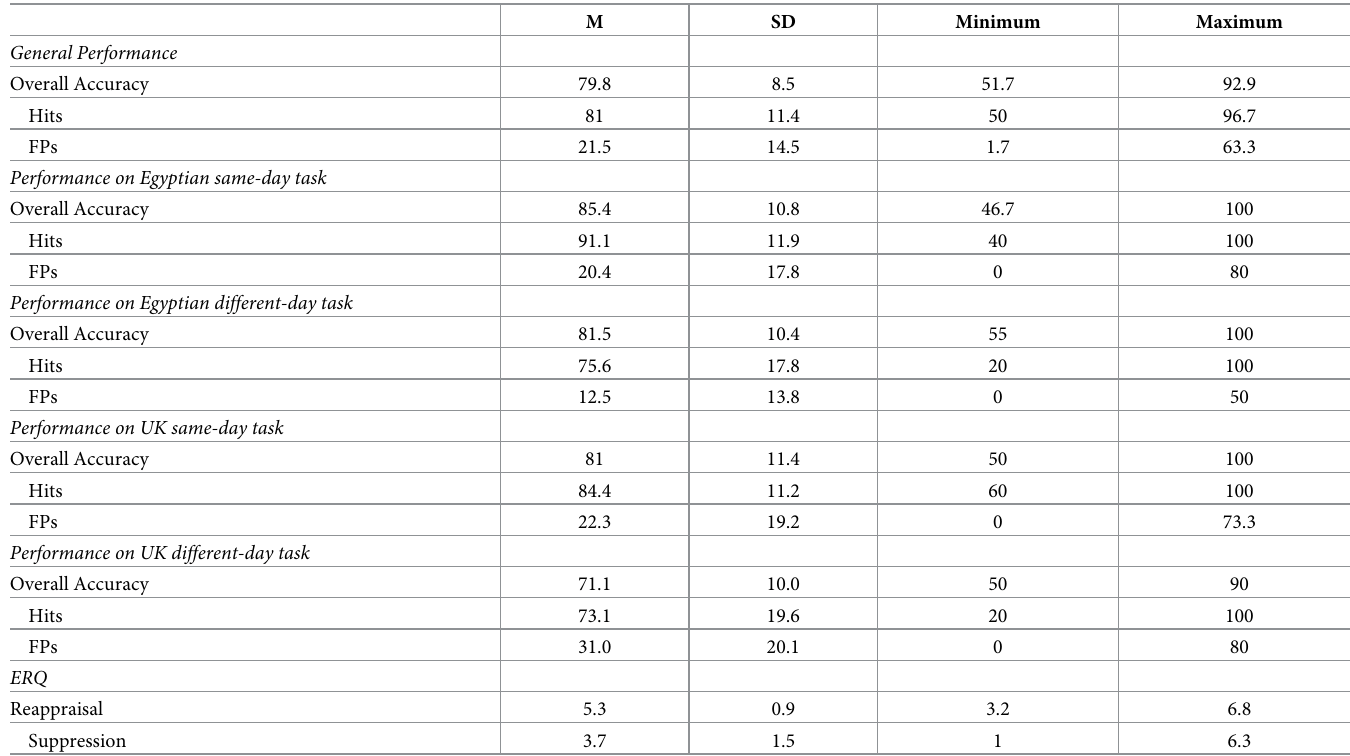
Table 3. Descriptive statistics for participants’ responses on the 1-in-1 face-matching tasks and ERQ strategies in Experiment 2.